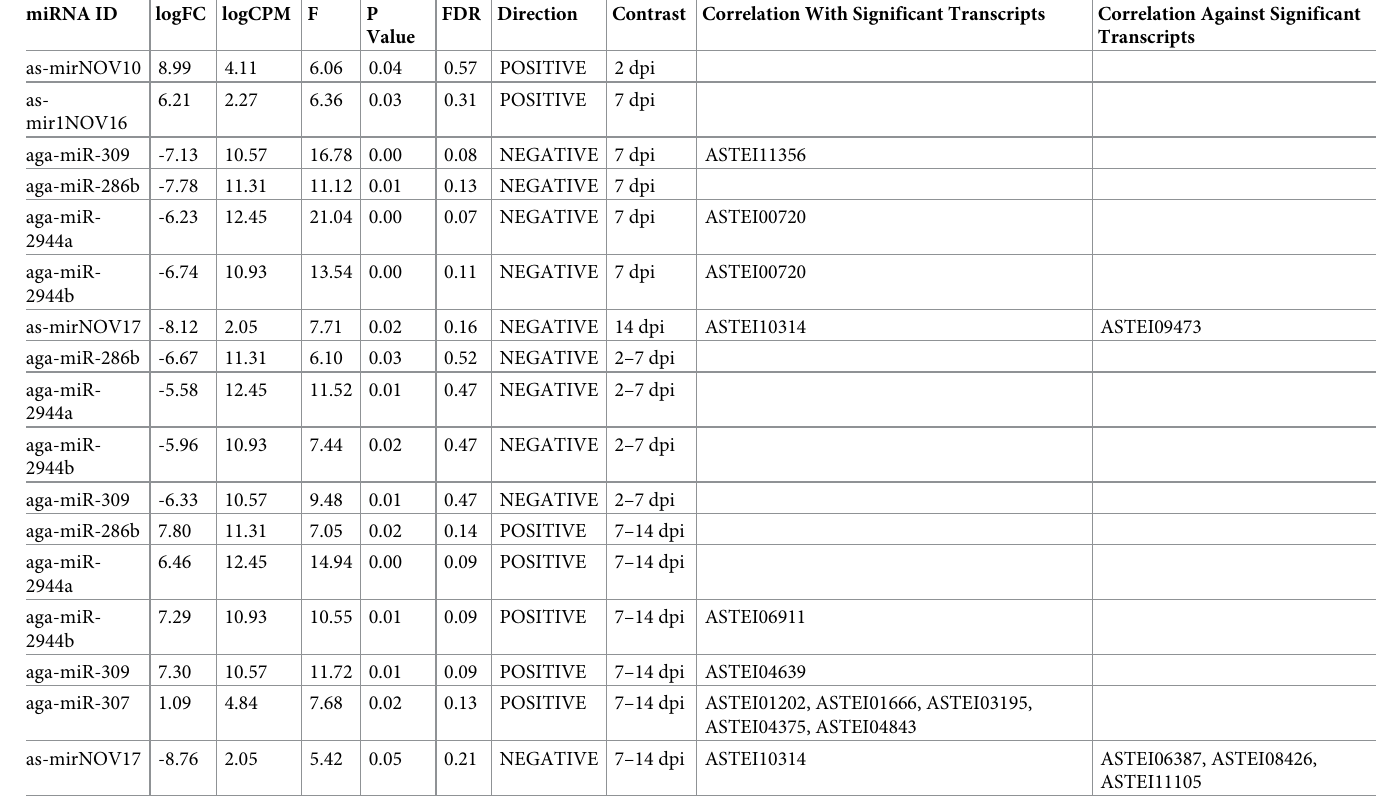
Table 1. Differentially expressed An . stephensi miRNAs in response to Mayaro virus infection. Correlation with regulated transcript targets in the same or opposing direction in the specified contrasts are also displayed. miRNA ID logFC logCPM F P FDR Direction Contrast Correlation With Significant Transcripts Correlation Against Significant Value